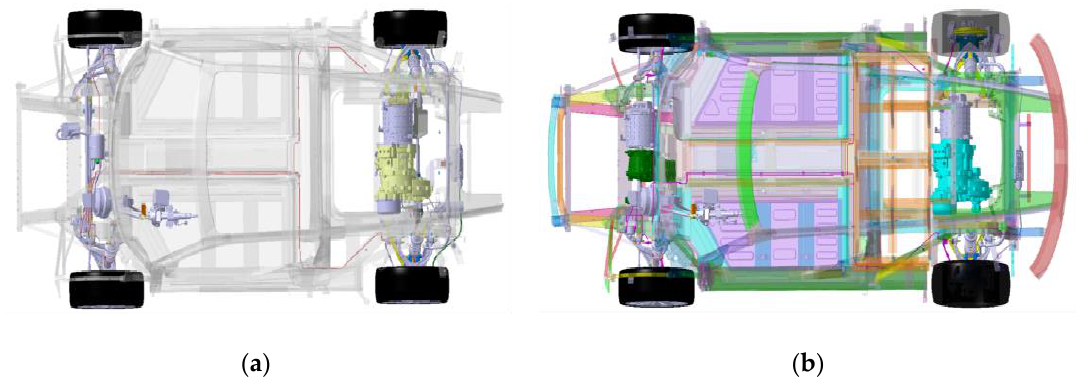
Figure 6. i-KERD applications in ( a ) 4 × 2 Drive and ( b ) 4 × 4 Drive.